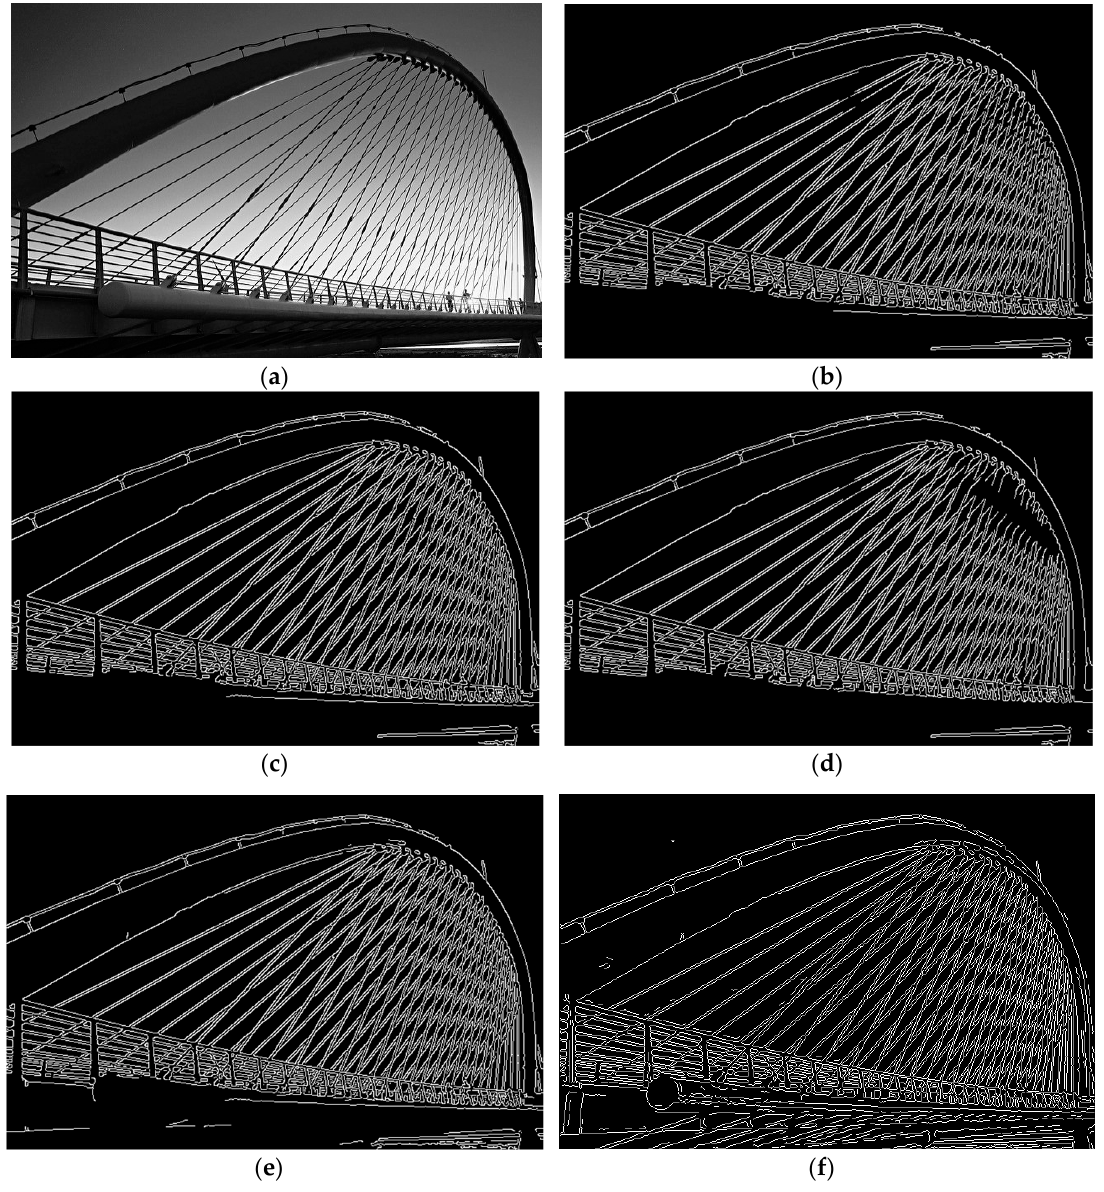
Figure 18. Bridge image comparison results of different methods. ( a ) Original image (640 × 428) [23]; ( b ) Gao and Liu’s method (TH H = 129, TH L = 65); ( c ) Song et al. proposed method (TH H = 129, TH L = 11); ( d ) Saheba et al.’s method (TH H = 154, TH L = 55); ( e ) Li and Zhang’s method (TH H = 64, TH L = 25); ( f ) TCEDA.